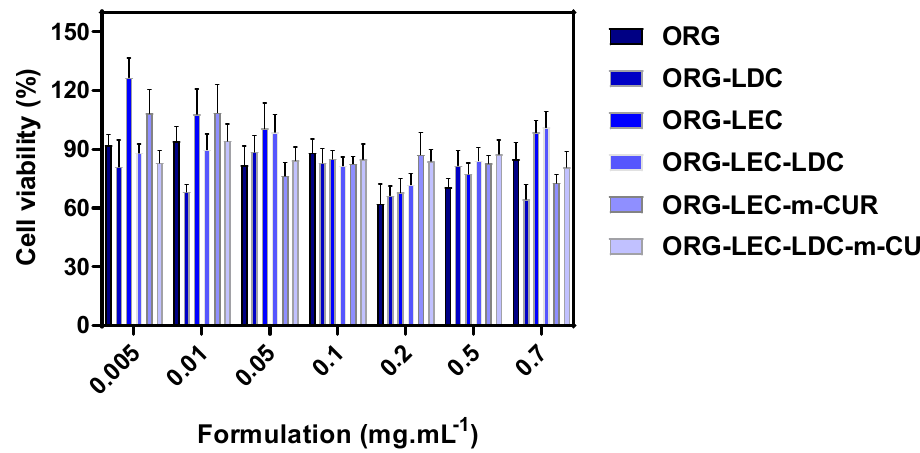
Figure 6. Cell viability percentage determined after HaCat cells treatment with ORG formulations ( n = 6/concentration) by using the Methylthiazolyldiphenyl-tetrazolium bromide (MTT) reduction